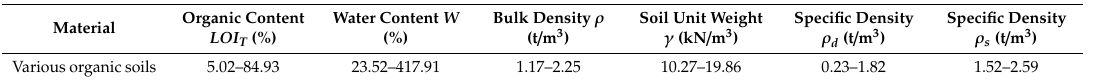
Table 1. Index properties of organic soils at the Rzeszow site.